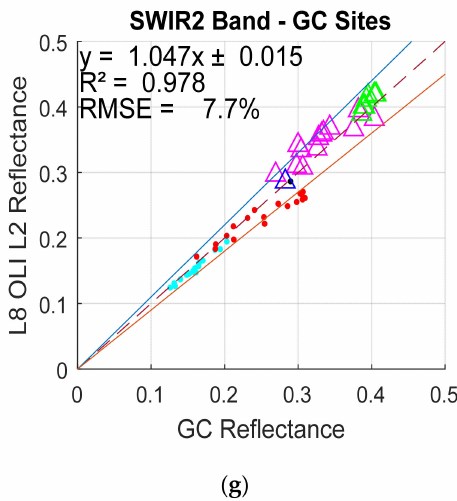
Figure 15. ( a – g ) Scatter plots of the OLI L2 SR product vs. ground truth (GT) measurements for the CA-SWIR2 bands. Bright cover sites are represented with a ‘ ∆ ’ and vegetation cover sites are represented with a ‘ •